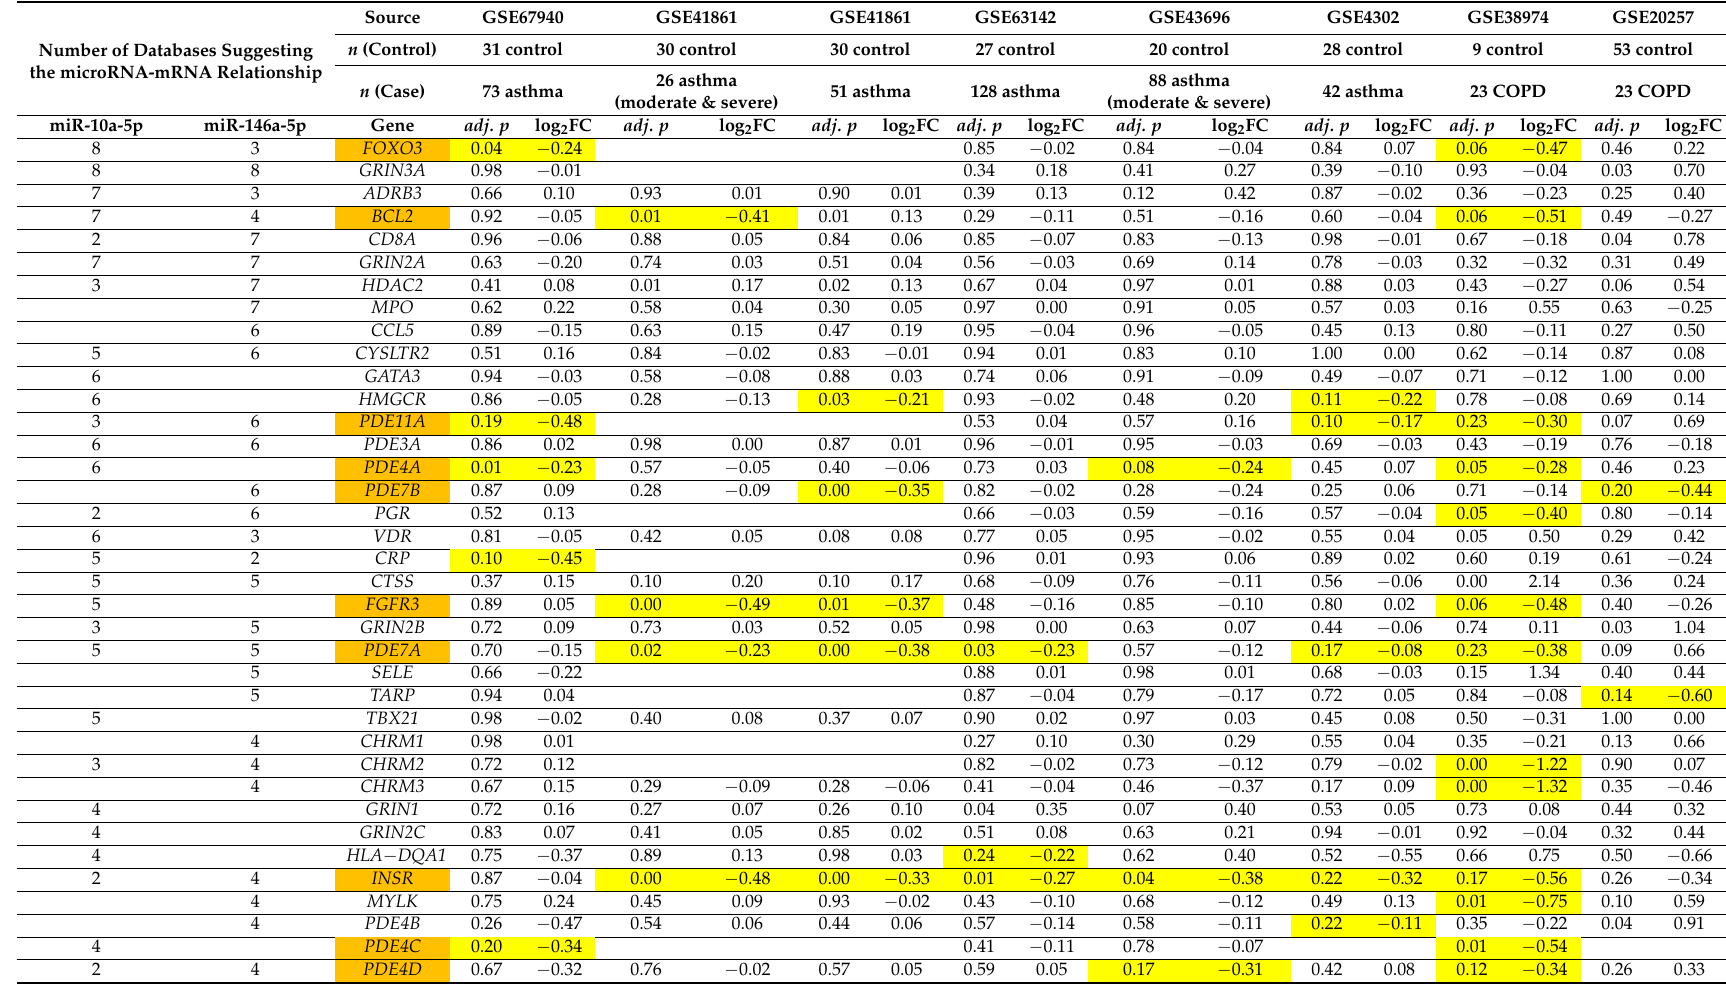
Table A1. The expression levels of predicted microRNA targets in asthma/chronic obstructive pulmonary disease (COPD) bronchial epithelial